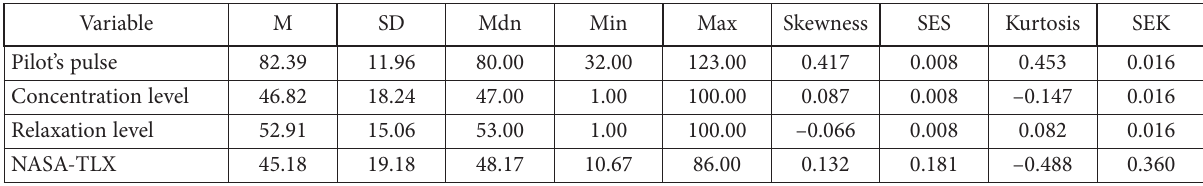
Table 1. Basic descriptive statistics of quantitative